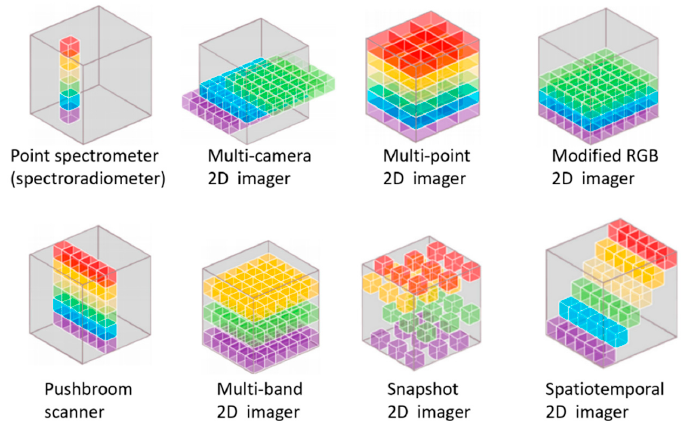
Figure 4. The data cube structure of different spectral sensors. The number of bands and resolution is shown as an example and does not indicate true sensor capability (adapted from [130]).